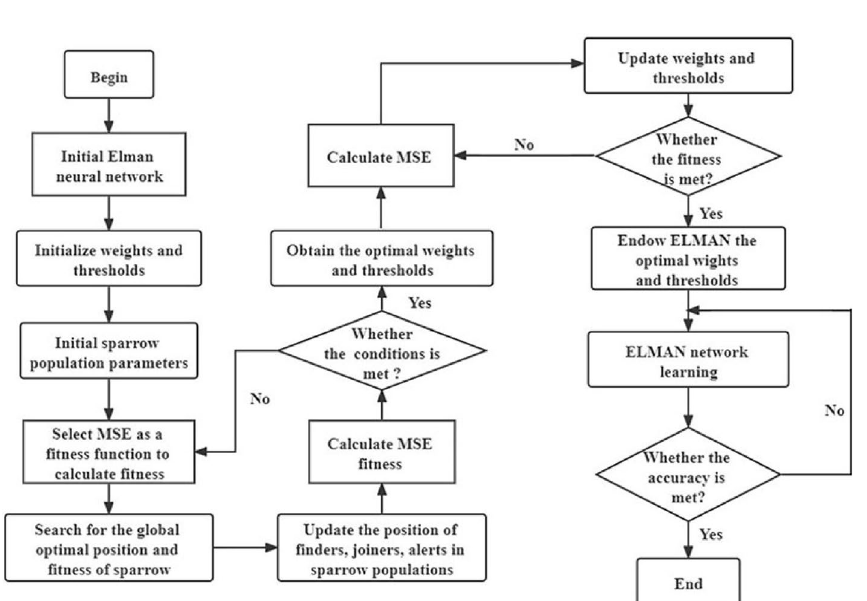
Figure 5. Flow chart of SSA optimizing